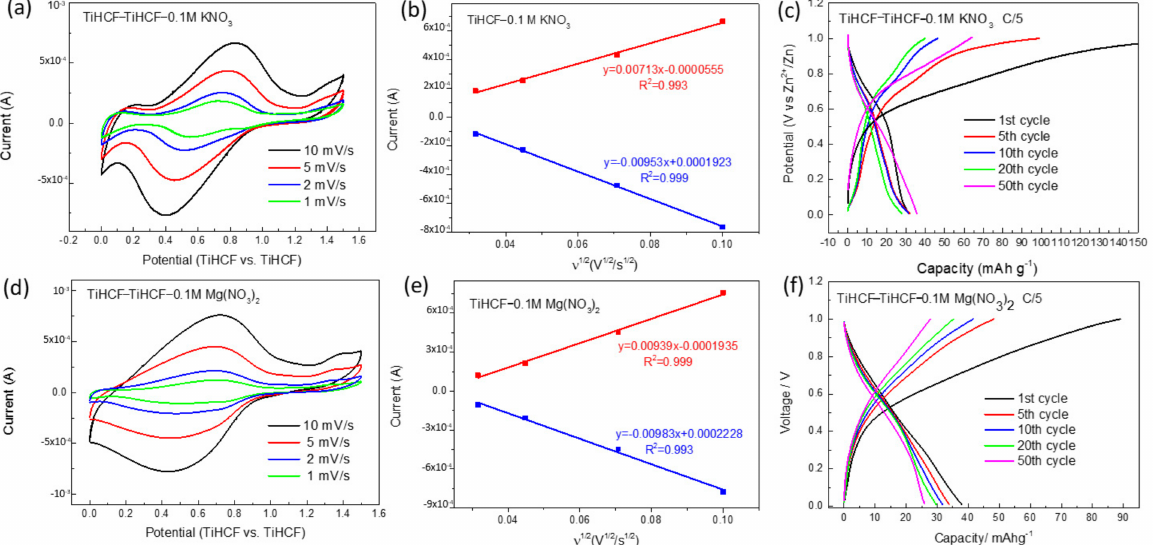
Figure 6. ( a , d ) Cyclic voltammetry of TiHCF full cell in 0.1 M KNO 3 and 0.1 M Mg(NO 3 ) 2 electrolytes at potential range 0~1.5 V; ( b , e ) relationship between the peak currents ( I p ) and the square root of the scan rate ( v 1/2 ) in 0.1 M KNO 3 and 0.1 M Mg(NO 3 ) 2 electrolyte; ( c , f ) Galvanostatic charge–discharge profiles of TiHCF symmetric batteries in 0.1 M KNO 3 and 0.1 M Mg(NO 3 ) 2 electrolyte at